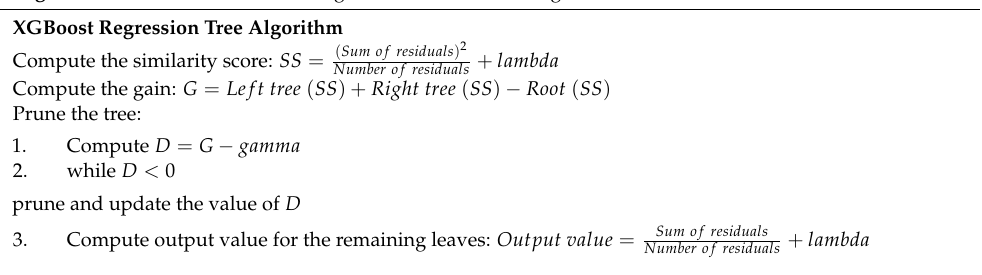
Algorithm 2 Pseudocode for building the XGBoost tree for regression XGBoost Regression Tree Algorithm